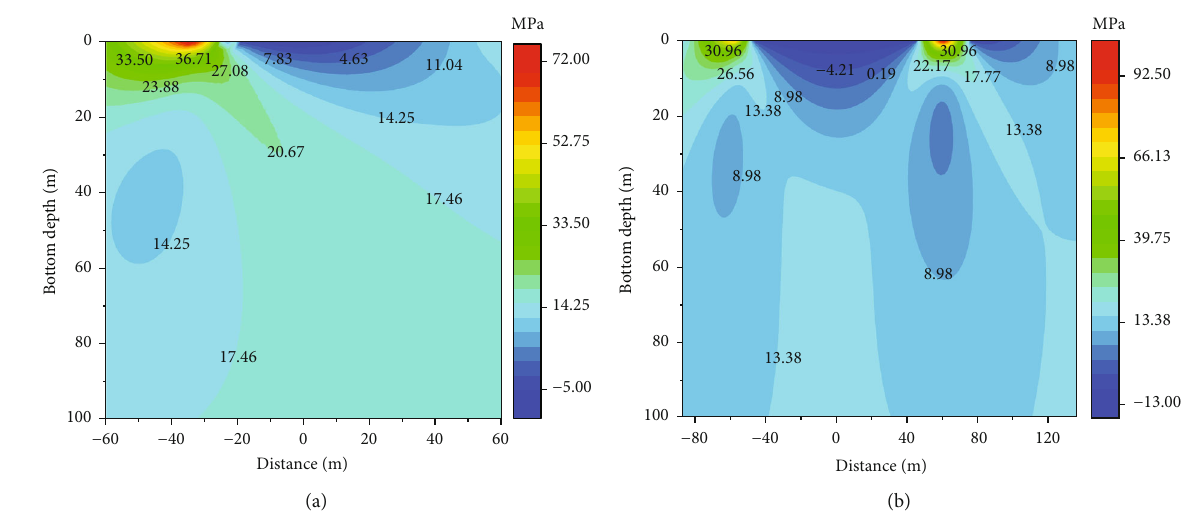
Figure 7: The isoline of the horizontal stress: (a) along the inclination; and (b) along the